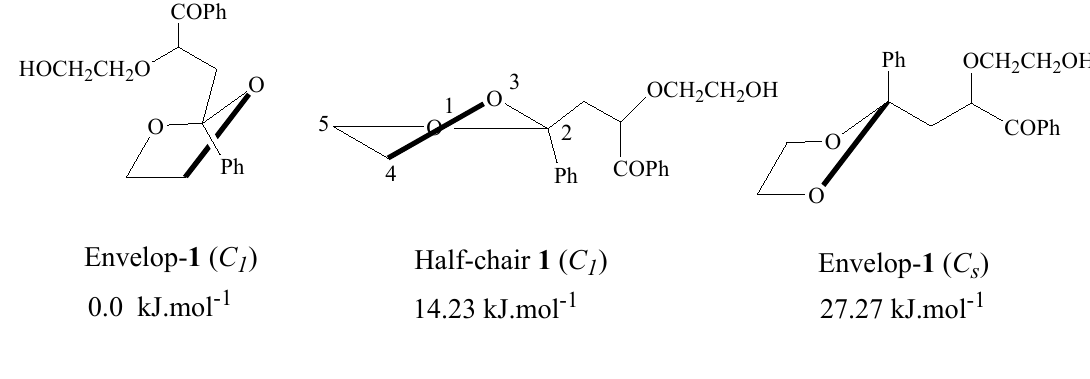
Figure 1. Energy of the different conformations of 2,2- disubstituted 1,3-dioxolane 1 from HF/6-31G* calculations.